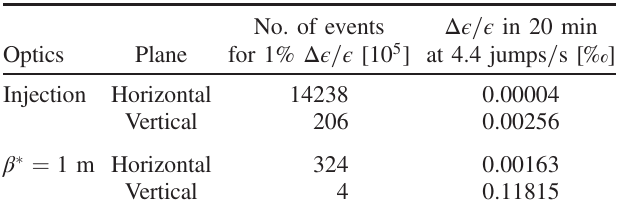
TABLE II. Number of reactions of the regulation loop to the flux jumps needed to get a 1% emittance blowup and emittance growth in 20 minutes (approximate duration of an energy ramp) at a 4 . 4 events = s rate for injection optics and β (cid:1) ¼ 1